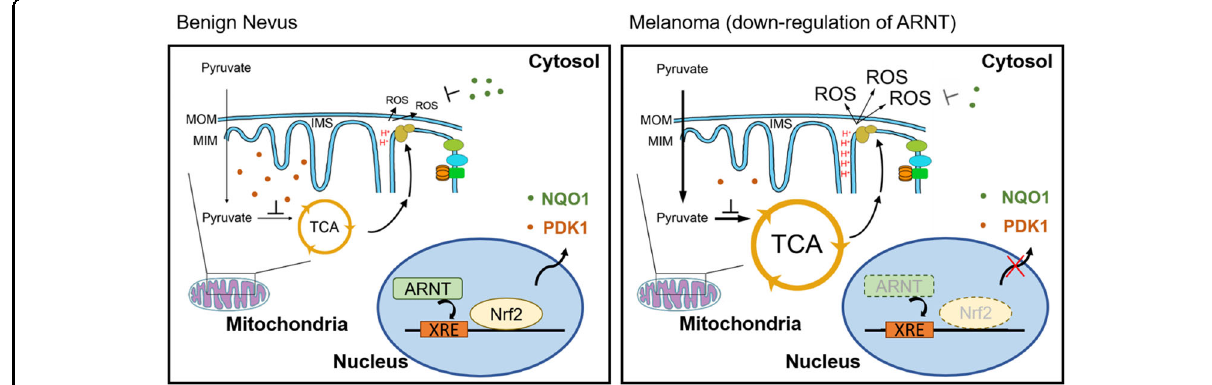
Fig. 8 Schematic diagram of the ARNT/PDK1 pathway in regulation of melanoma metastasis. The metastatic properties of tumor cells are promoted in downregulation of ARNT as melanoma occurrence. The ARNT de fi ciency represses transcription factor Nrf2, resulting in downregulation of PDK1 and NQO1 to promote ROS production and tumor